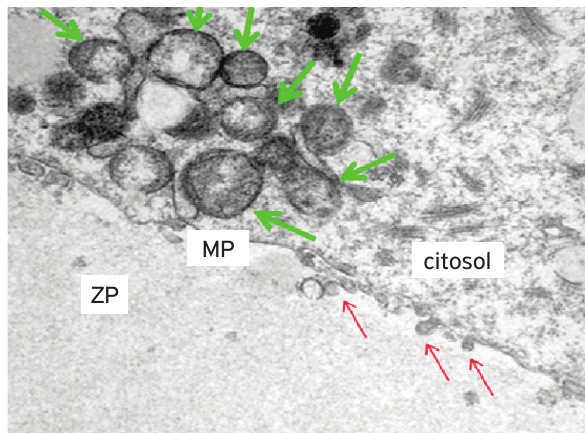
Figura 15. Embrião exposto aos vírus e ao ao extrato etanólico da casca de Punica granatum (Grupo G MP: membrana plasmática. Setas vermelhas: perturbação da